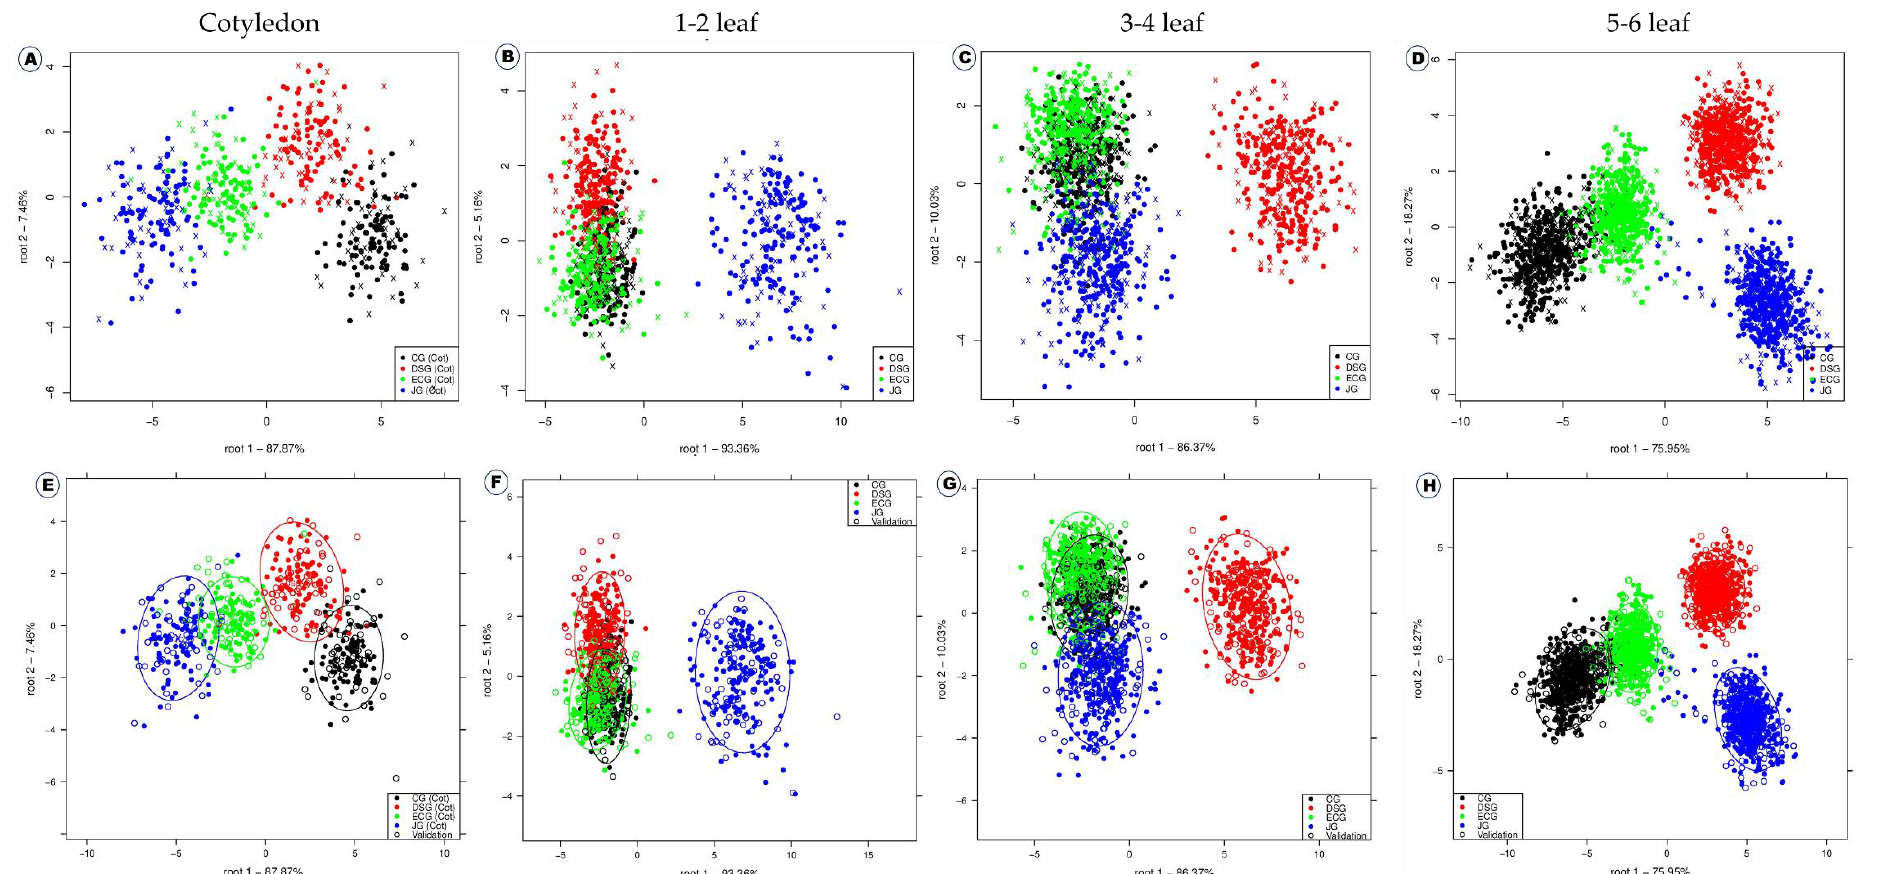
Figure 3. Linear discriminant analysis for the effective discrimination of four growth stages of four B. juncea varieties without confidence circles ( A – D ) and with confidence circles ( E – H ).